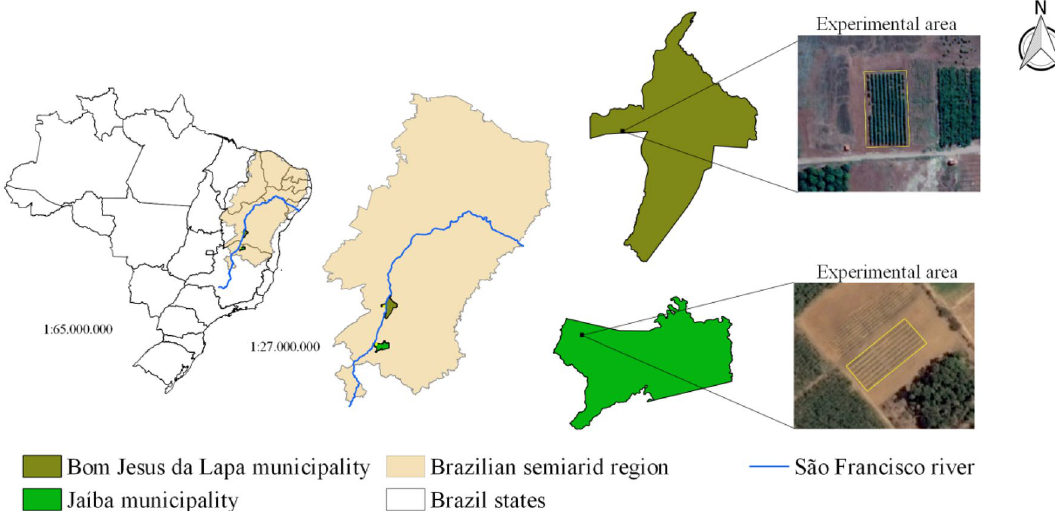
Figure 1. Location of the experiments showing the cities which each one is inserted, the proximity of both in relation to the São Franscisco river and their location in relation to the Brazilian semiarid region. The figure was elabored using the open source software QGIS 25 using the Basemap: Google Satellites (obtained through